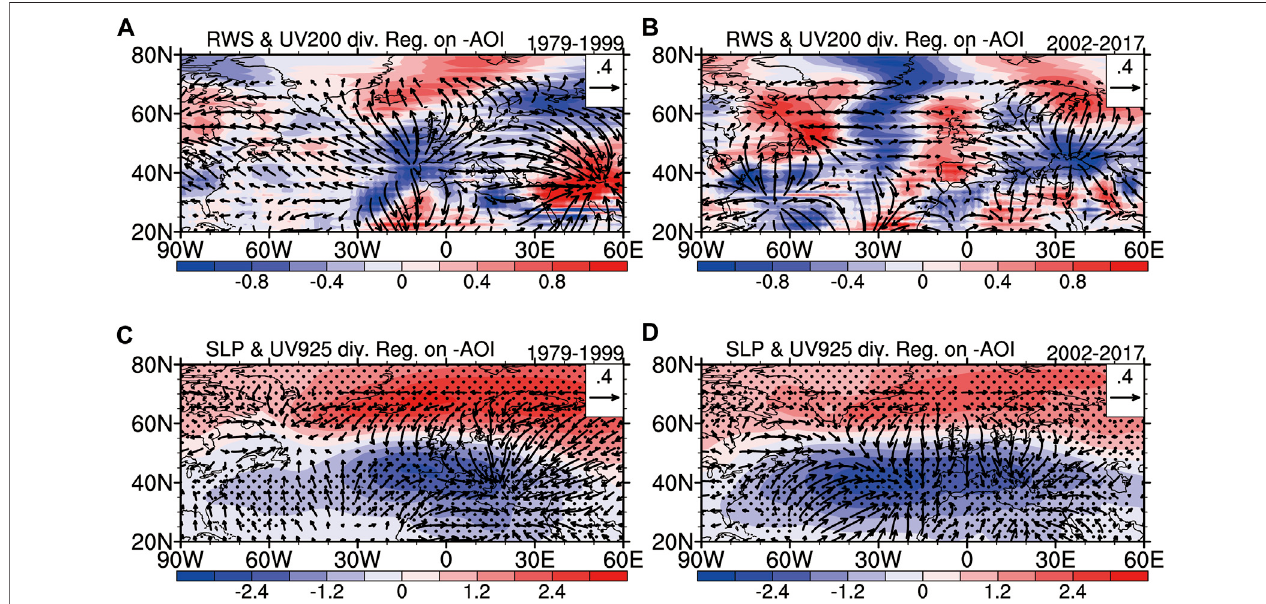
FIGURE5|(A,B) Regressionmaps oftheRossby wavesource(shading;units: 10 – 10 s − 2 )anddivergentwind(vectors;units: m s − 1 )at200 hPaupon − AOIduring (A) 1979 – 1999and (B) 2002 – 2017. (C,D) Asin (A,B) butfordivergentwind(vectors;units:m s − 1 )at925 hPaandSLP(shading;units:hPa).Thedottedareasin (C,D) indicate statistical signi fi cance at the 95% con fi dence level based on the Student ’ s t